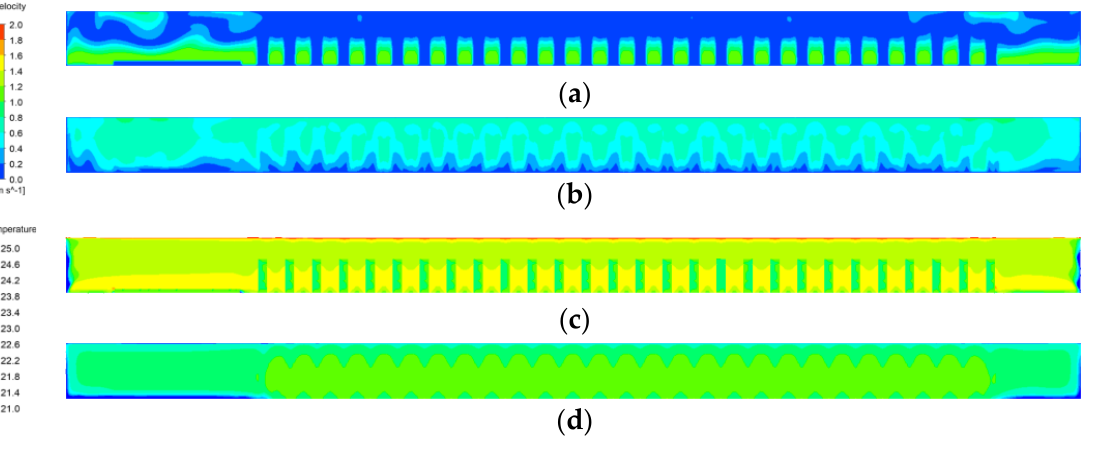
Figure 15. Coupled ventilation characteristics in the plain area of: ( a ) x = 4000 mm, velocity; ( b ) x = 600 mm, velocity; ( c ) x = 4000 mm, temperature; ( d ) x = 600 mm, temperature.